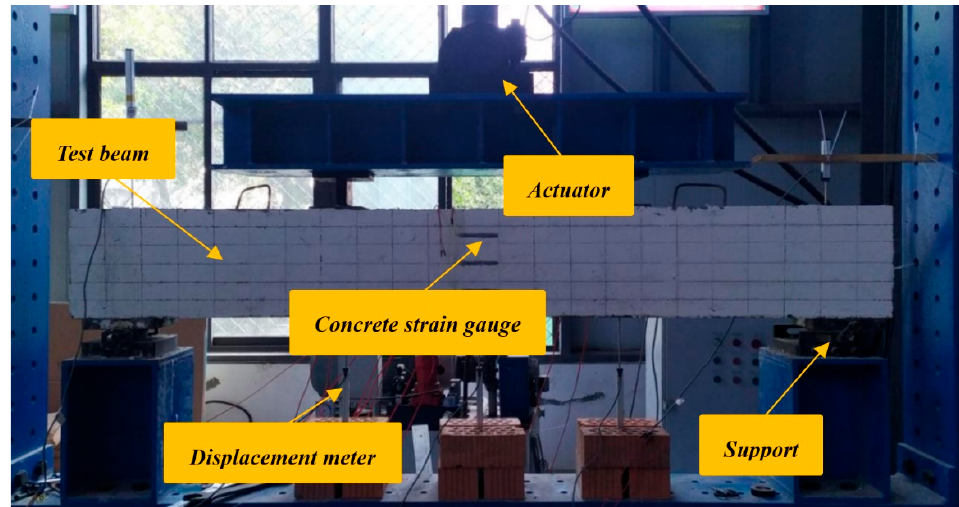
Figure 3. Test setup.